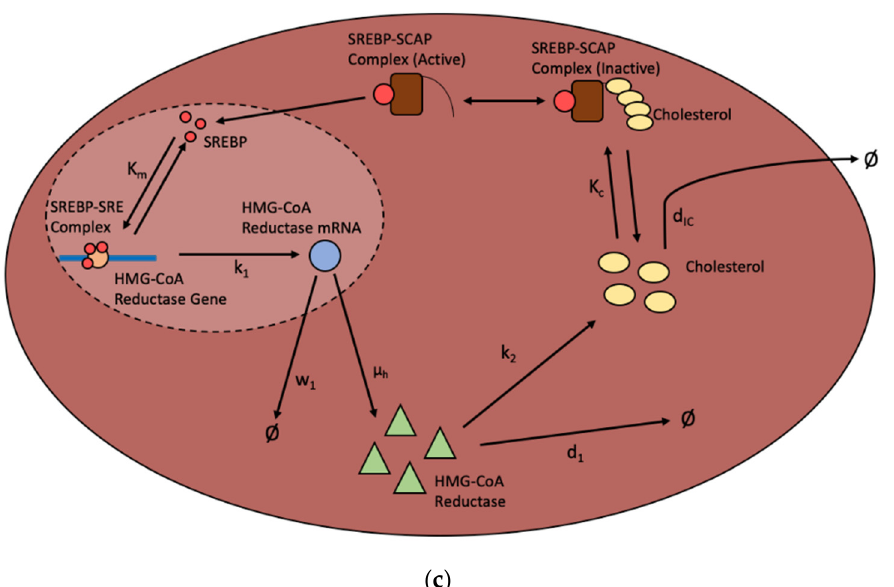
Figure 2. SREBP regulation model (Model 1 in Table 1) of cholesterol biosynthesis. ( a ) The promoting factors effect on transcription and translation. ( b ) The binding of cholesterol to the SREBP-SCAP complex. ( c ) SREBP regulation. As the concentration of cholesterol increases, SREBP is locked in the ER. When cholesterol concentrations are lower, the SREBP transcription factor can enter the nucleus and increase the transcription rate. G: HMG-CoA reductase gene; S: SREBP molecule; m: HMG-CoA reductase mRNA; HMGR: HMG-CoA reductase; IC: intracellular cholesterol; x: amount of SREBP required to bind to HMG-CoA reductase gene; y: amount of cholesterol required to bind to SREBP-SCAP complex. Equations, along with parameters, for SREBP regulation model can be found in A1 to A7 in Appendix A [35].